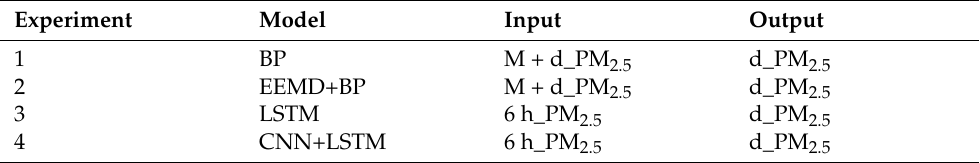
Table 1. Experimental